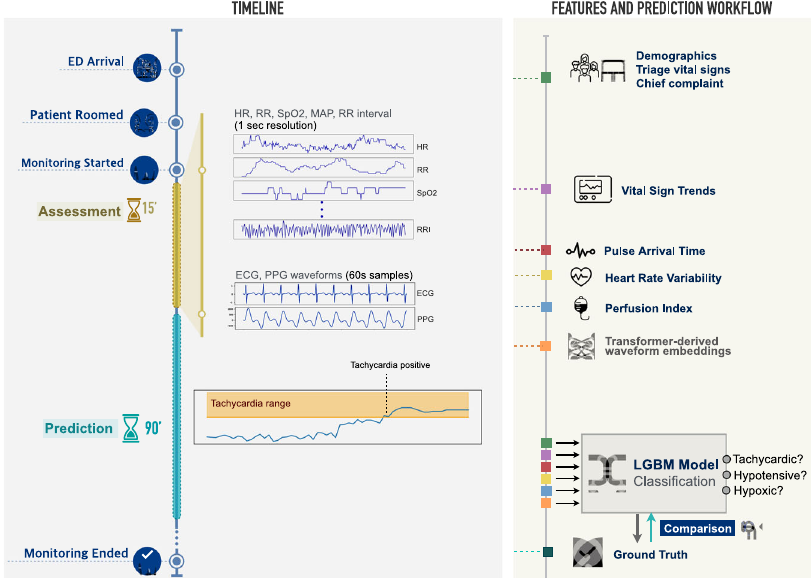
Fig. 1 Data sources and modeling approach. Patient demographics, chief complaint, and initial vital signs are collected upon ED arrival. After rooming, and concurrent with other workup, the patient enters a 15-minute assessment period during which six numeric measures (HR, RR, SpO2, MAP, Beat-to-Beat RR Interval, Perfusion Index) are recorded at 1-second resolution, and 60-second segments of lead-II ECG and PPG waveforms are sampled. Triage data and vital sign trends are combined with physiologic measures derived from RR intervals and ECG/PPG waveforms (heart rate variability, pulse arrival time), as well as deep learning-derived representations of ECG and PPG waveforms, in a model that predicts whether a patient will develop tachycardia, hypotension, or hypoxia in the 90 min following the initial assessment